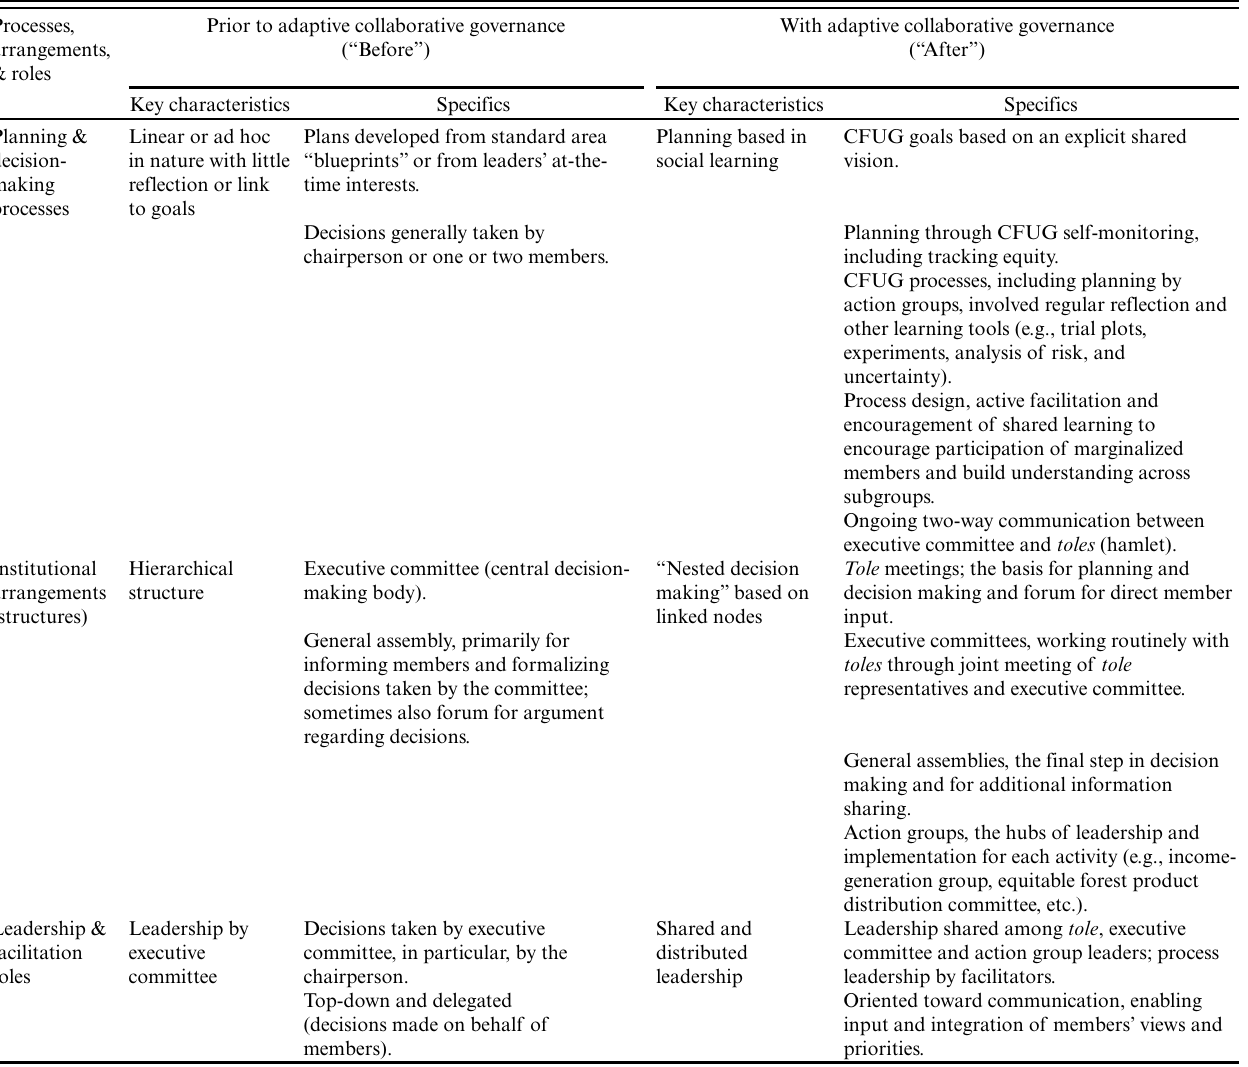
Table 1 . Governance processes, arrangements, and leadership roles: comparing pre- and with adaptive collaborative approach (n = 11). Notes: The “Before” data are from the preadaptive collaborative governance period (1999 in the long-term sites and 2004 in the short term sites); the “After” data are from the “with” period (2006/2007 in all sites). CFU G =community forest user group. Sources: key informant interviews, observation, review of CFUG meeting records, background study, and final assessment reports. Processes,